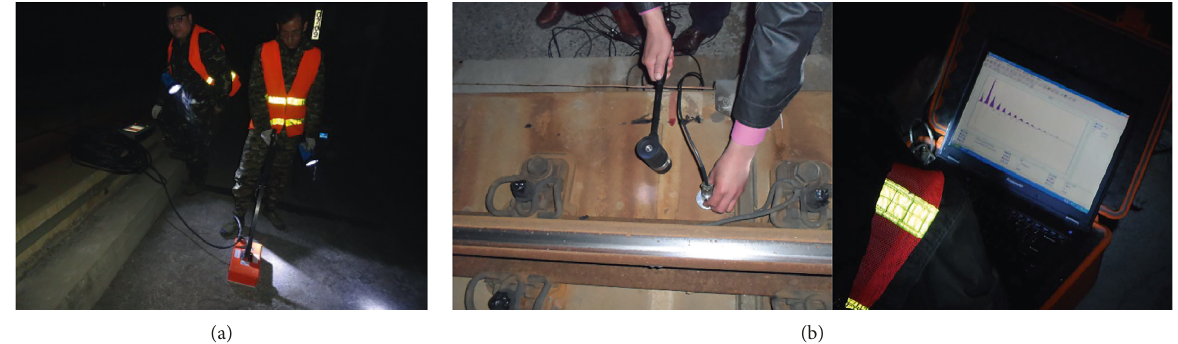
Figure 3: Detecting the interlayer of the ballastless track-subgrade affected by mud pumping. (a) Detecting for subgrade bed under the waterproof seal layer based on GPR. (b) Detecting for subgrade bed under the ballastless track structure based on